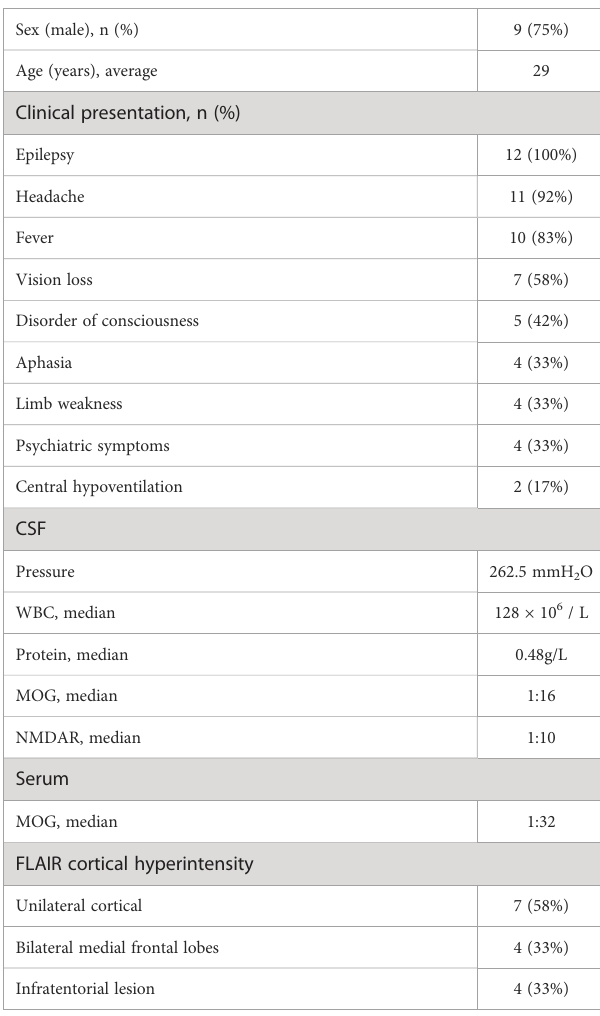
IVMP+IVIG. Of the 12 patients, six recovered with fi rst-line treatment. The second line of treatment included mycophenolate